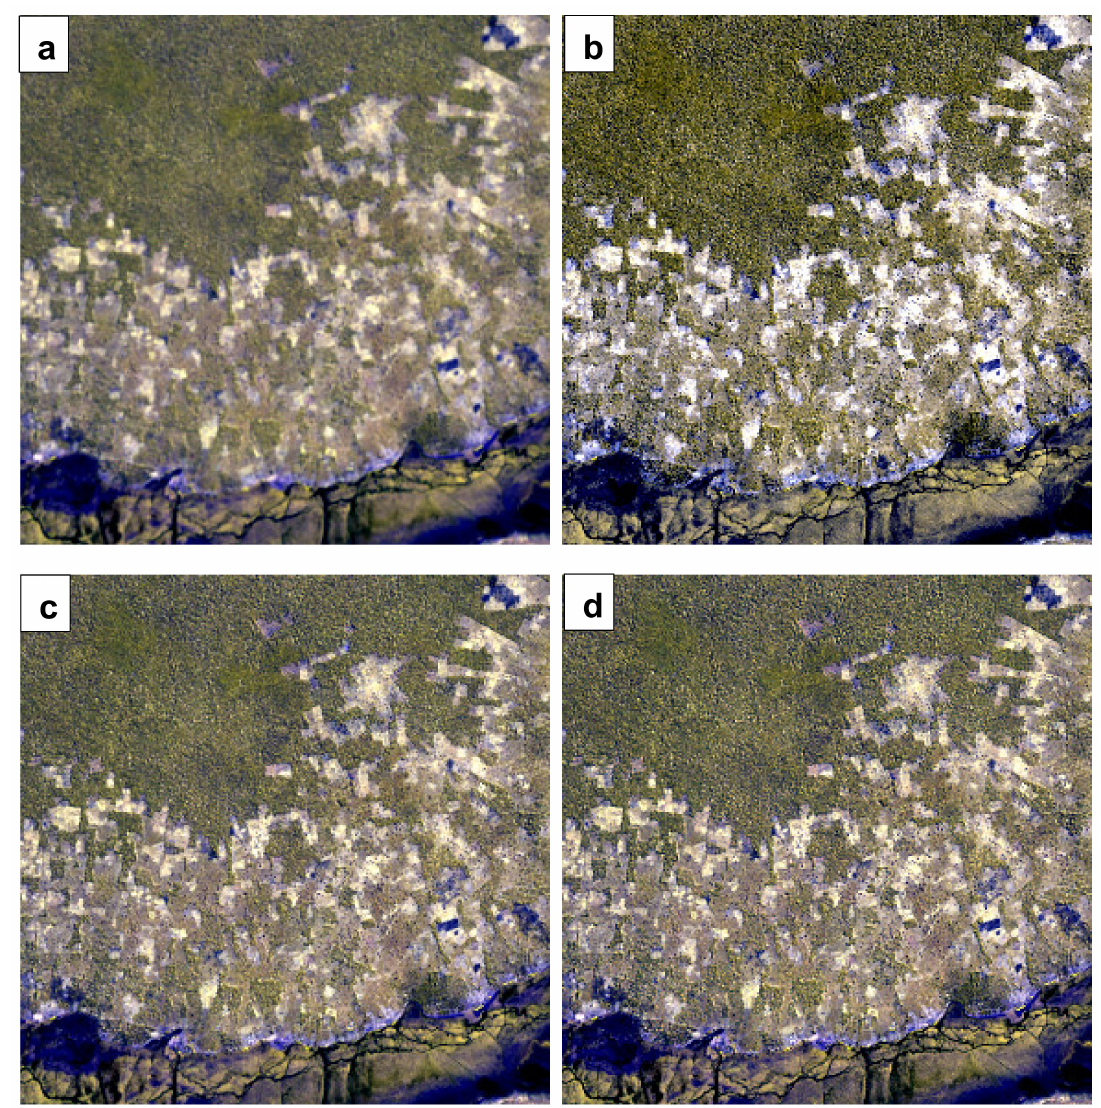
Figure 4. Study site 1 false color surface reflectance images, composed of 1800 × 1800 3.333 m pixels covering 6 × 6 km ( a ) Sentinel-2 NIR (855–875 nm), red-edge (773–793 nm), and SWIR (1565–1655 nm) reflectance bilinear resampled from 20 m, ( b ) Planetscope NIR reflectance and synthetic Sentinel-2 red-edge and SWIR reflectance, ( c ) Sentinel-2 false color reflectance HPM sharpened from 20 m, and ( d ) Sentinel-2 false color reflectance M3 sharpened from 20 m. Images oriented with north at the top of the image. Site and image dates summarized in Table